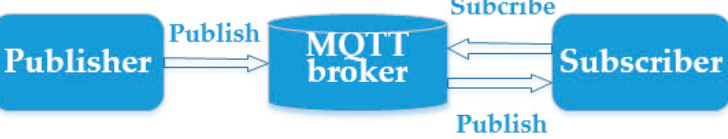
Figure 11. Message Queuing Telemetry Transport (MQTT) model.